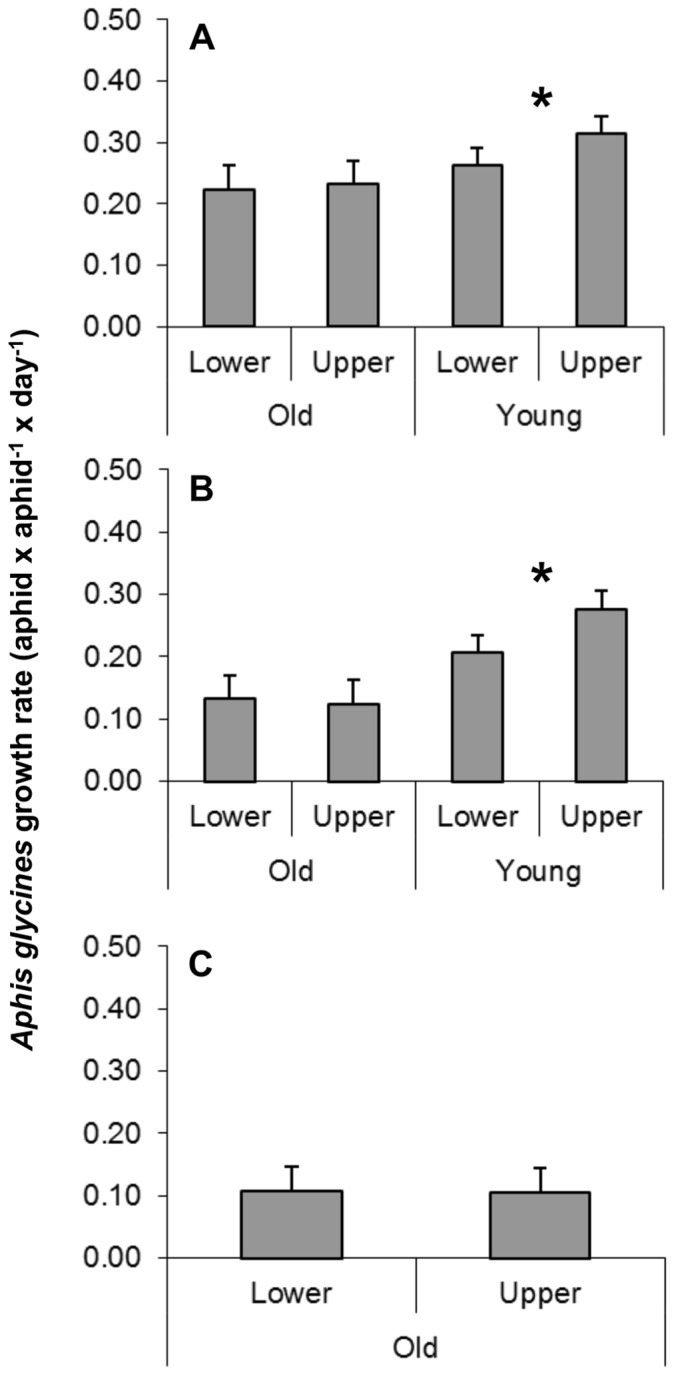
Bottom-up effects of within-plant quality on A. glycines population growth rates under predator exclusion.(A)–(C) present results for trials 1–3, respectively. Old versus young plants were compared in trials 1 and 2, and only old plants were available for trial 3. Upper nodes represent the 3–4 top nodes (∼ 10% of the plant canopy) and lower nodes represent the rest of the plant nodes. All graphs show means (+1 SE) of A. glycines intrinsic rate of increase (aphids×aphid−1×day−1); asterisks indicate significant differences between plant parts within old or young plants (t-test, P<0.05).